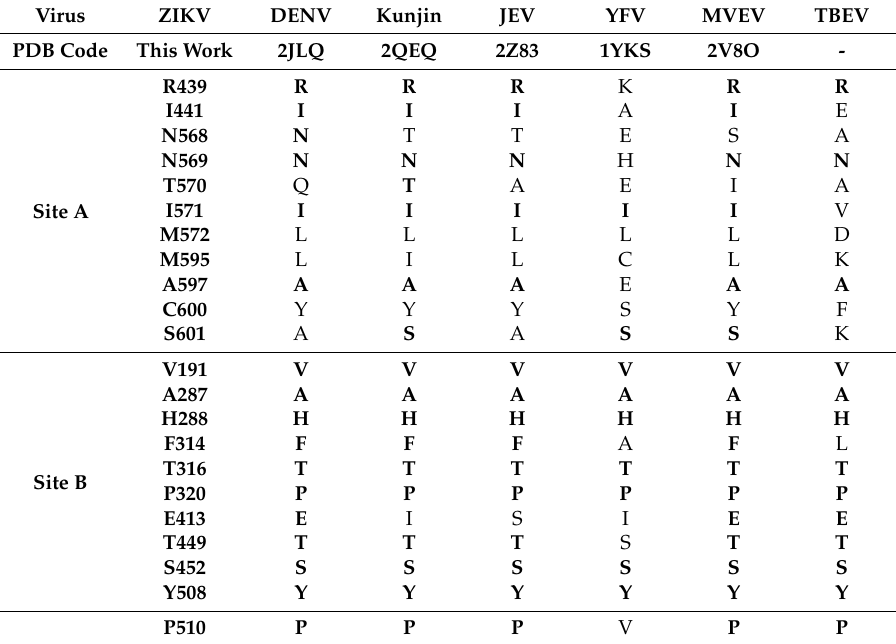
Table A1. Residues forming the binding sites A and B in flaviviral NS3 helicases.